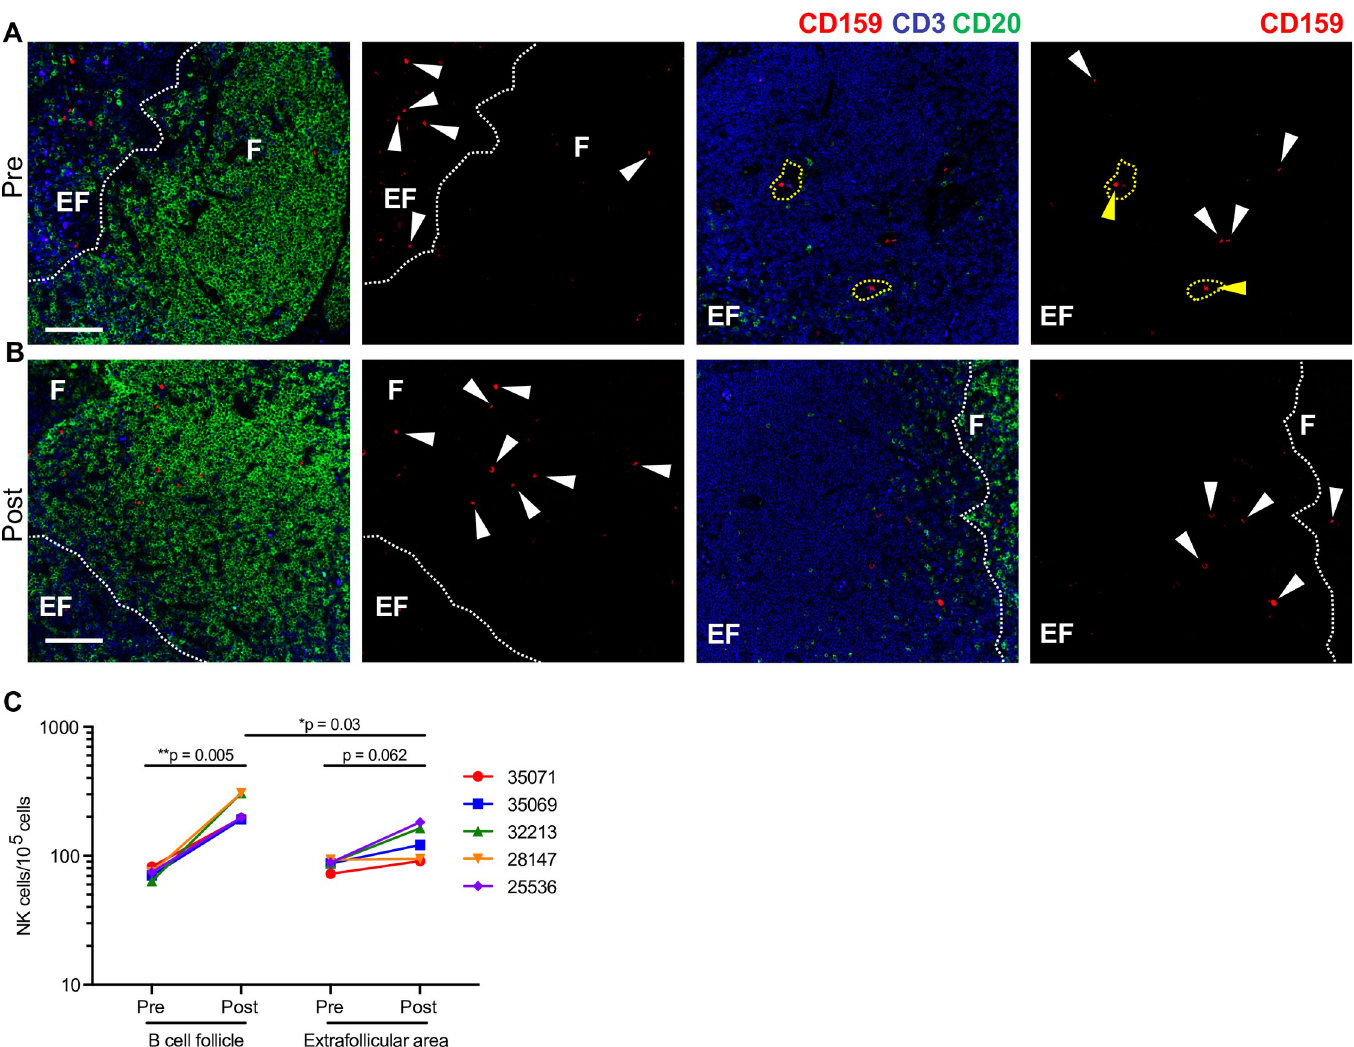
Fig 6. N-803 triggers NK cell migration from blood vessels and extrafollicular spaces into B cell zones of lymph nodes. Representative images from peripheral lymph nodes before (A) and 5 days after (B) N-803 treatment show a significant increase of NK cells (arrowheads) within B cell follicles (F) with only a modest increase in NK cells found in extrafollicular (EF) regions. Notably, many NK cells prior to N-803 treatment are found within blood vessels (yellow arrowheads), while most NK cells following N-803 treatment were found within the lymph node parenchyma (white arrowheads), specifically adjacent to or within B cell follicles. Scale bar is 100 μ m.